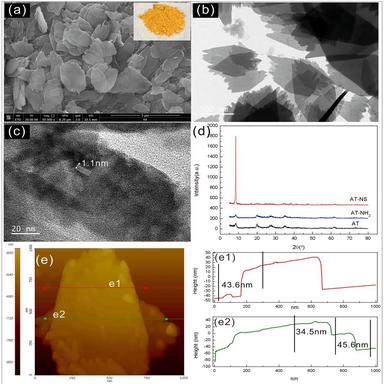
The SEM (a) and TEM (b), HRTEM (c) characterization of AT-NS; (d) The XRD patterns of AT, AT-NH2 and AT-NS. (e) the AFM tomography and corresponding section view of the topography indicating the thickness of the AT-NS.